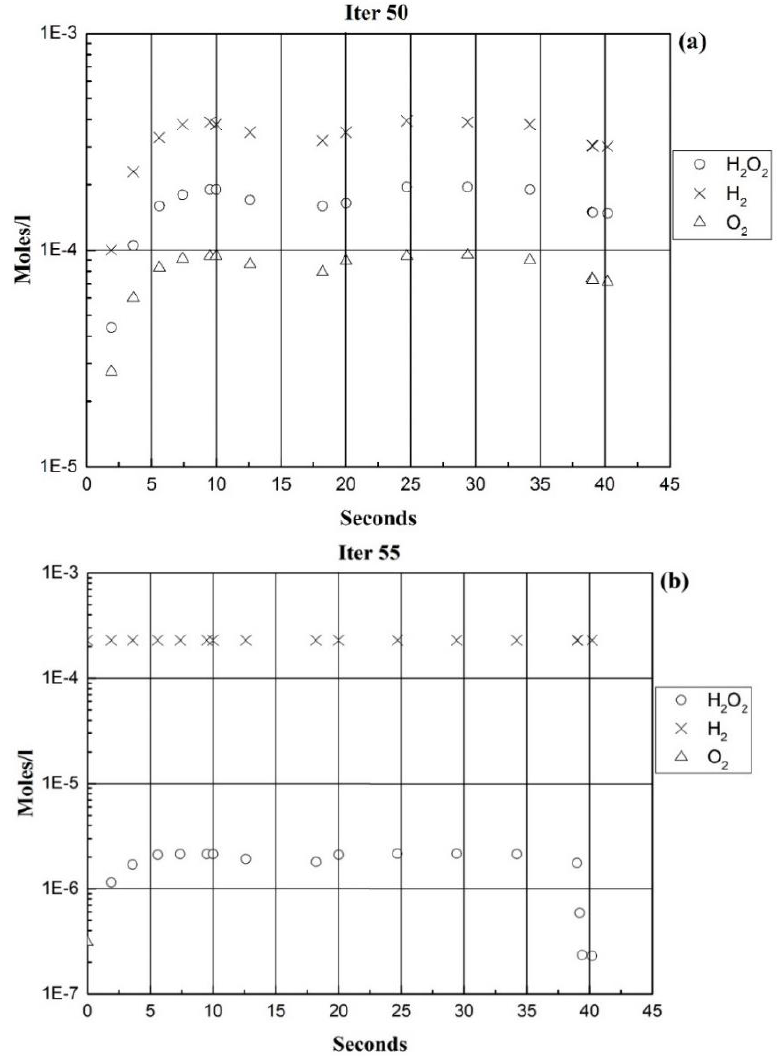
Figure 25. Radiolysis of water in the Studsvik INCA loop at 50 °C, with ( a ) no added hydrogen and ( b ) 5 cm 3 (STP)/kg H 2 O (after Christensen et al. [28]). © 1996 ITER Organization. This image is hereby used courtesy of the ITER Organization.